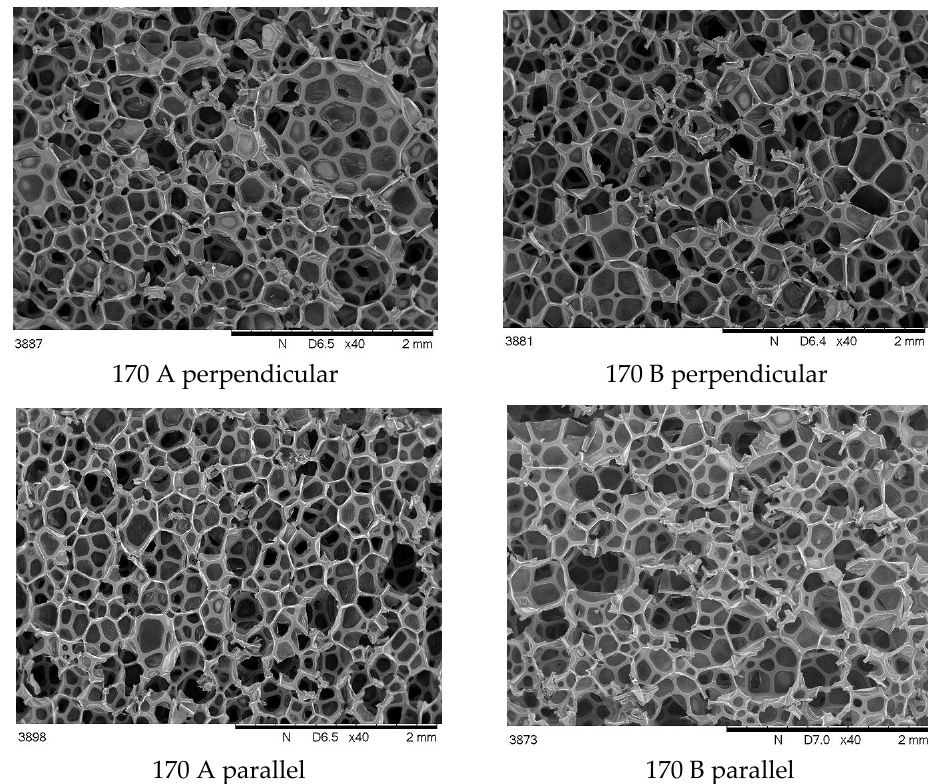
Figure 4. SEM cross-sectional images of foams synthesized at 170 bar, taken perpendicular and parallel to the growth direction.